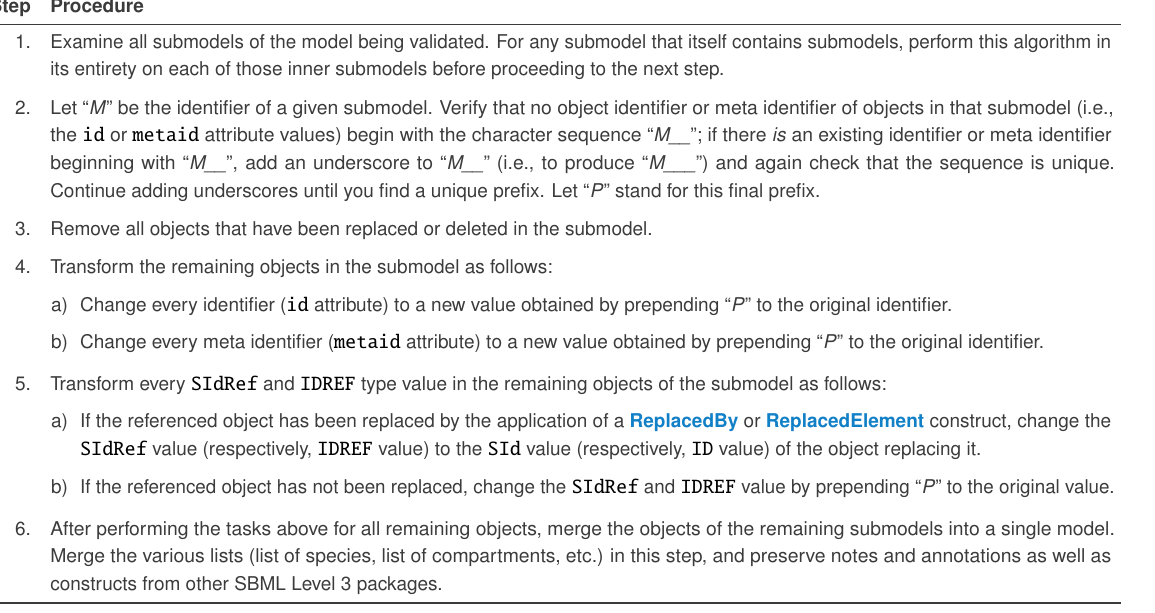
Figure 8: Example algorithm for “flattening” a model to remove Hierarchical Model Composition package